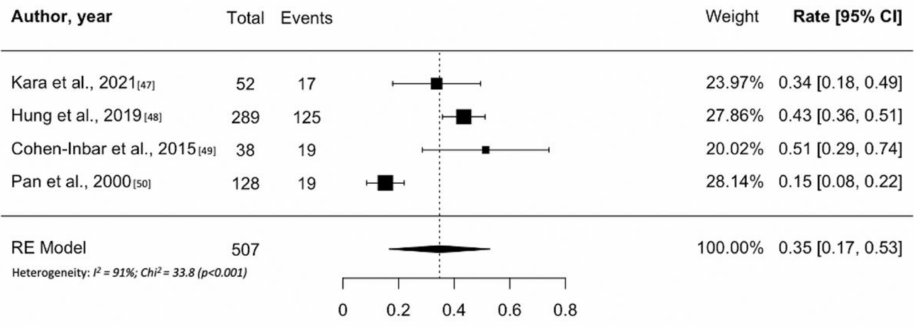
Figure 5. Forest plot of overall tumor control following Gamma Knife treatment for prolactin hormone-secreting pituitary